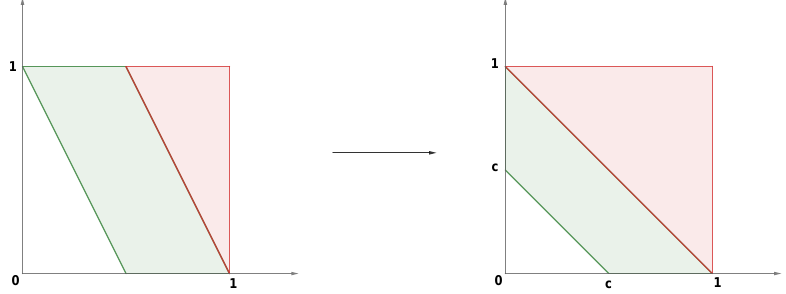
Figure 2. Normalized support of the observations (green) and corresponding forecast region